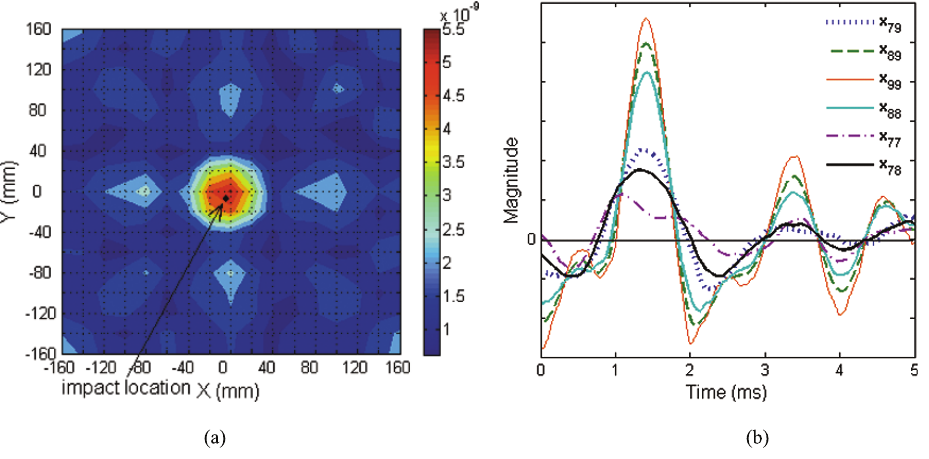
Fig. 3. Results of T-R procedure for impact identifications (a) Contour plot of peak value of the reconstructed signals (b) Time history of reconstructed signals near impact